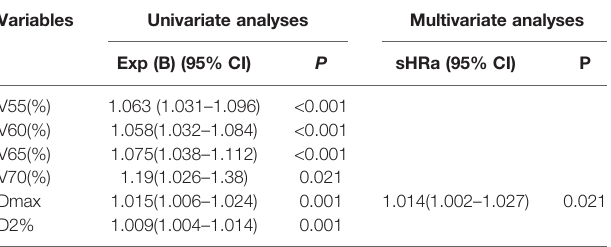
TABLE 3 | Estimated subdistribution hazard ratios for RION using univariate and multivariate cox regression models. Variables